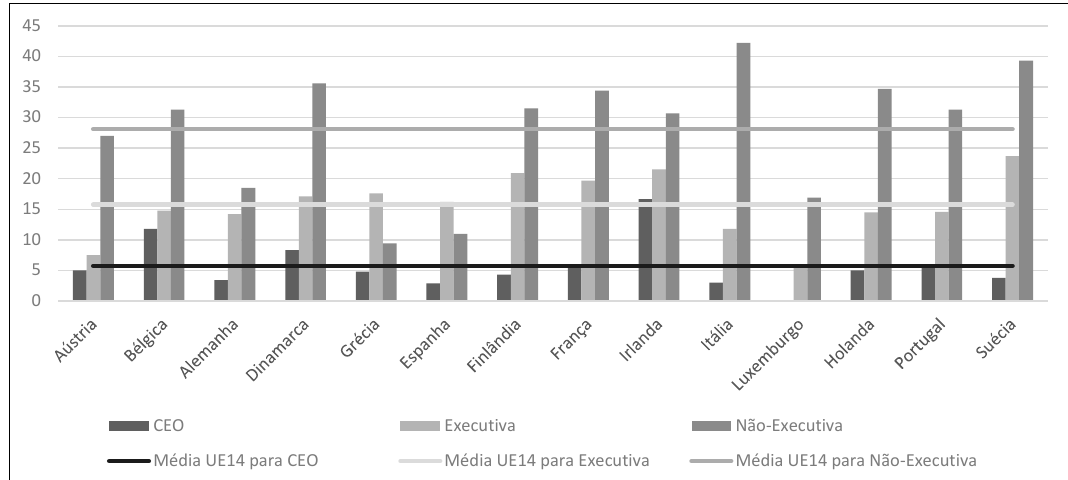
Figure 1. Percentage of women in CEO, executive and non-executive positions in the largest listed companies in EU14 in 2019. Source: data from European Institute for Gender Equality.